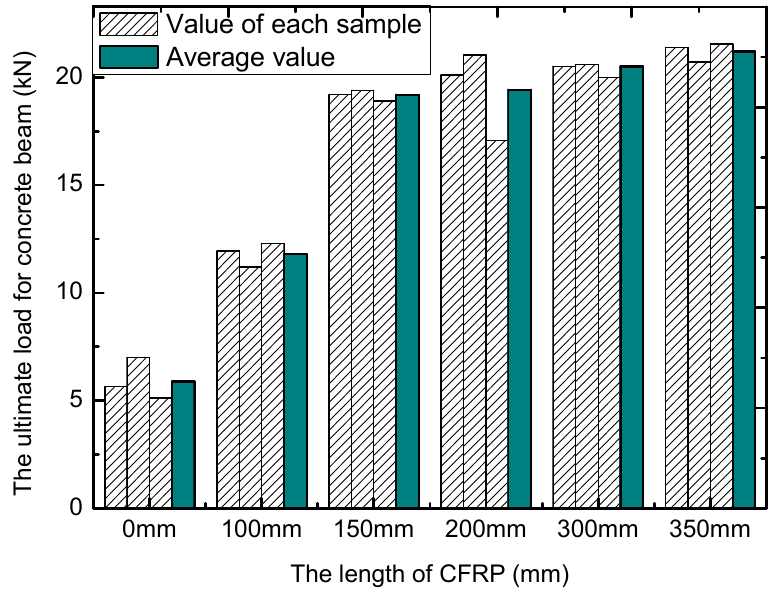
Figure 3. The plot of load-bearing capacity for concrete beams against the length of